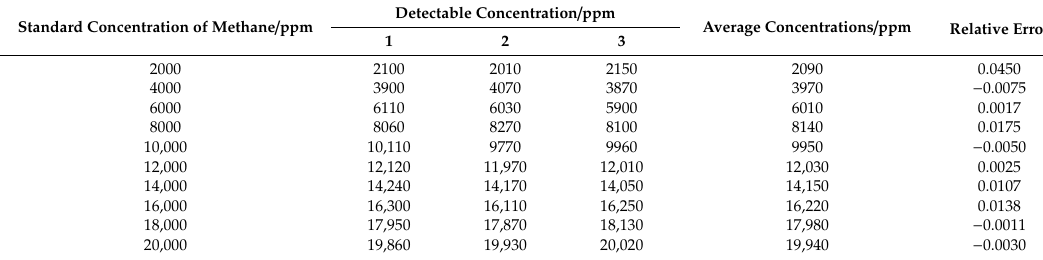
Figure 5. Linear relationship between optical power and methane concentration. Table 1. Methane gas test results and relative